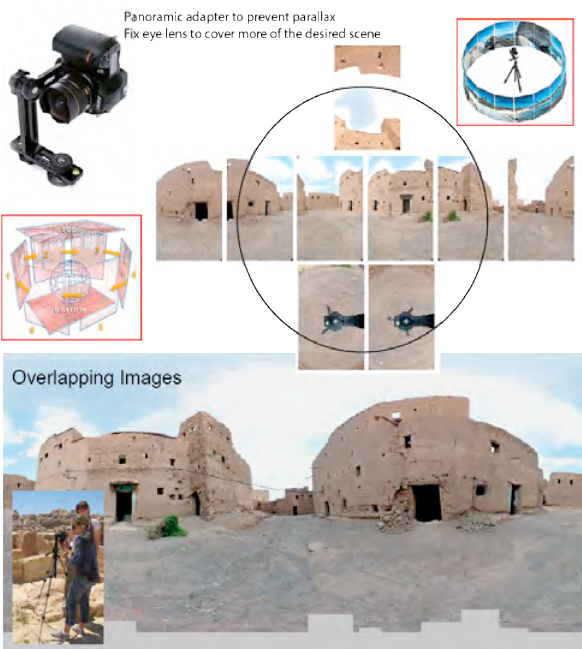
Figure 4: spherical panoramic